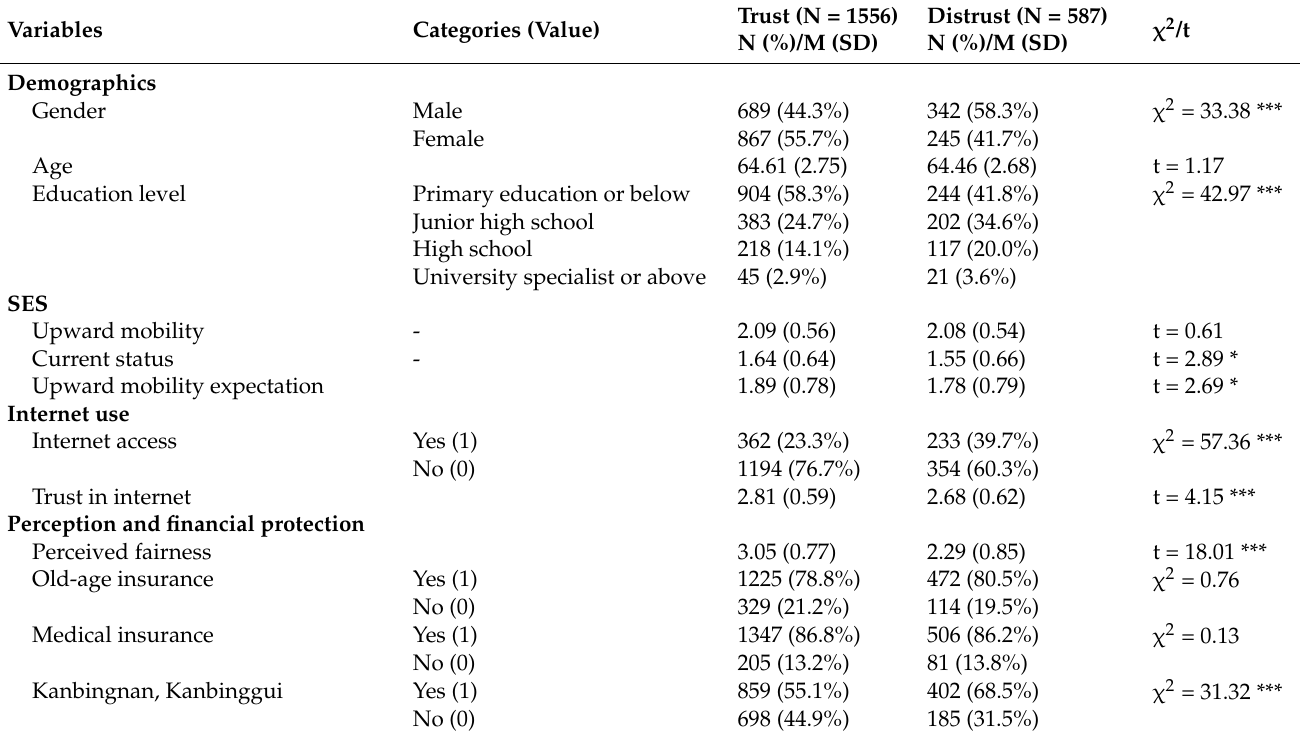
Table 2. Descriptive statistics of the elderly’s trust in the healthcare system on the four sets of independent